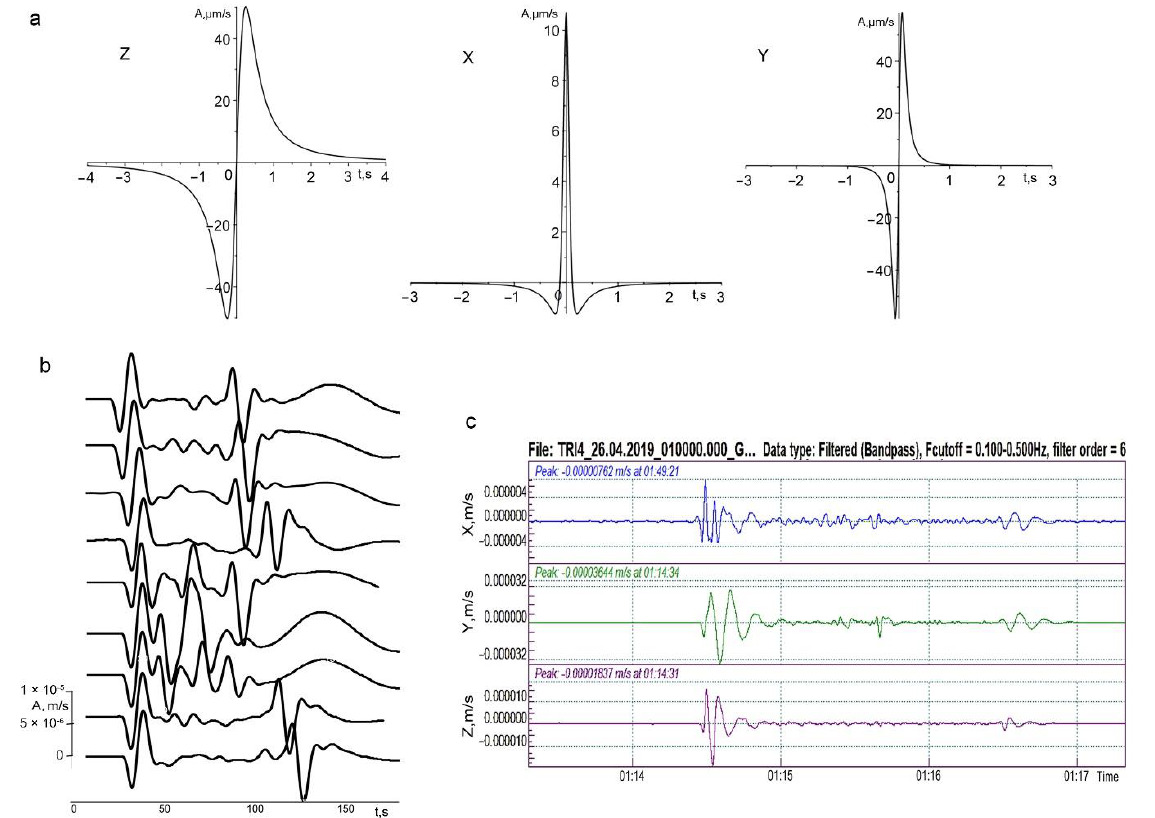
Figure 4. Calculated displacement velocity waveforms for 𝑍, 𝑋, and 𝑌 components recorded by the sensor when a single wheel set is moving ( a ); ( b ) Z-component waveforms using bandpass filter 0.01–0.1 Hz during the passage of cargo trains, the records are aligned by the first wave arrival from train; ( c ) experimental recordings of a passing train using bandpass filter 0.1–0.5